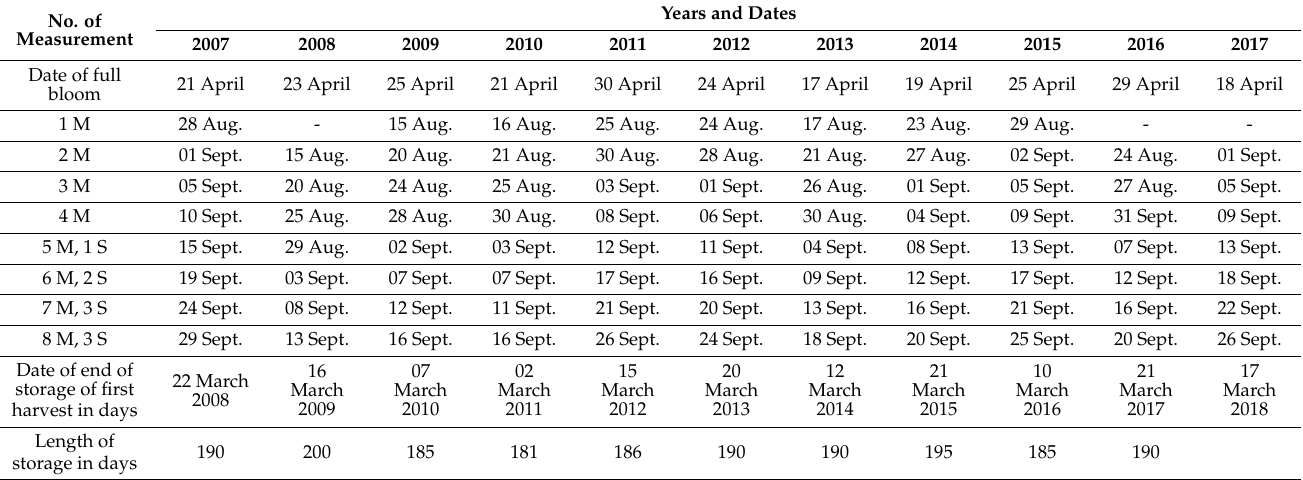
Table 1. Schedule of the